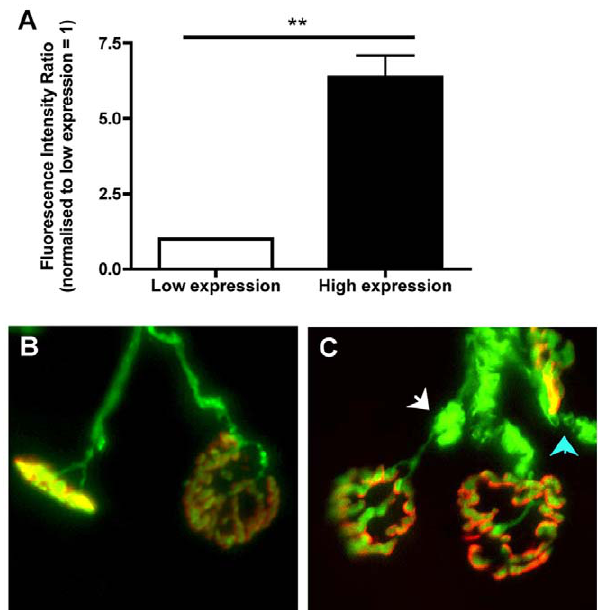
Figure 3. Increased incidence of morphological abnormalities at the NMJ in tissue banked from a strongly-expressing YFP-16 mouse colony. A - Bar chart (mean 6 s.e.m.) showing relative expression levels of YFP in the sciatic nerve of YFP-16 mice from the current Edinburgh colony (low expression), compared to YFP levels in tissue banked from a now defunct high-expressing YFP-16 colony previously held at the University of Leeds, quantified using fluorescent western blot (** P , 0.01 unpaired two-tailed t test). B–C - Representative micrographs showing NMJ morphology in low-expressing YFP-16 mice (B) compared to high-expressing YFP mice (C). Motor endplates are labelled and shown in red. Note the presence of large YFP accumulations in both axons (white arrow) and motor nerve terminals (blue) from the high-expressing tissue. Such morphological abnormalities were present in all preparations examined from high-expressing YFP